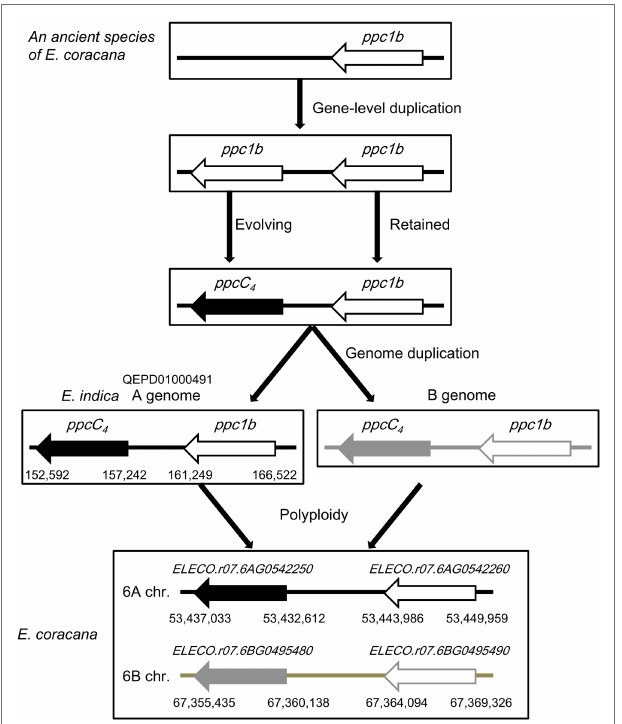
FIGURE 5 | An evolutionary model for ppc1b and ppcC 4 in Eleusine coracana .